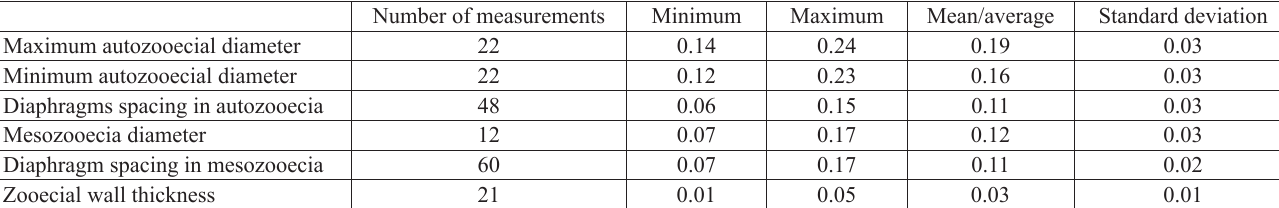
Table 1. Measurements (in mm) of Homotrypa cochlea sp.